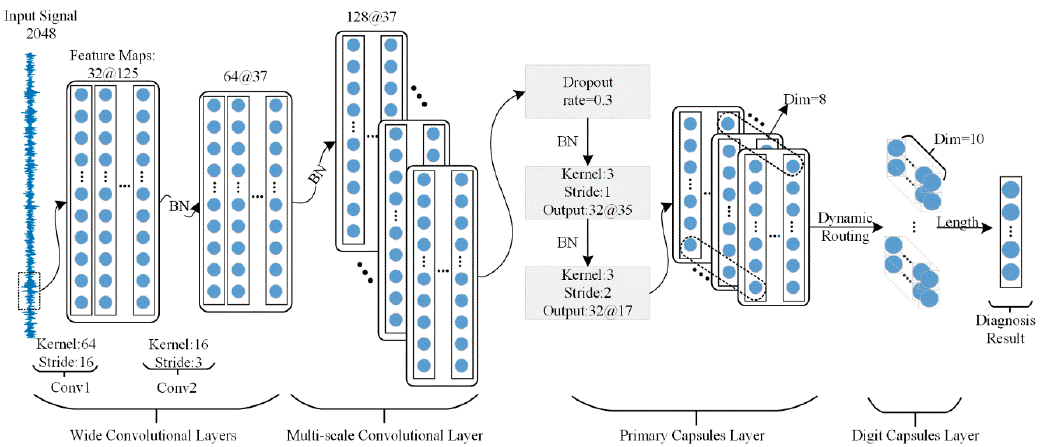
Figure 1. Framework of the novel capsule network based on wide convolution and multi-scale convolution (WMSCCN). The a @ b indicates that the number of current feature maps is a and the size is b. BN stands for Batch Normalization technology, and Dim denotes the dimension of the capsule. Conv1 and Conv2 denote the first and second convolutional layers, respectively.